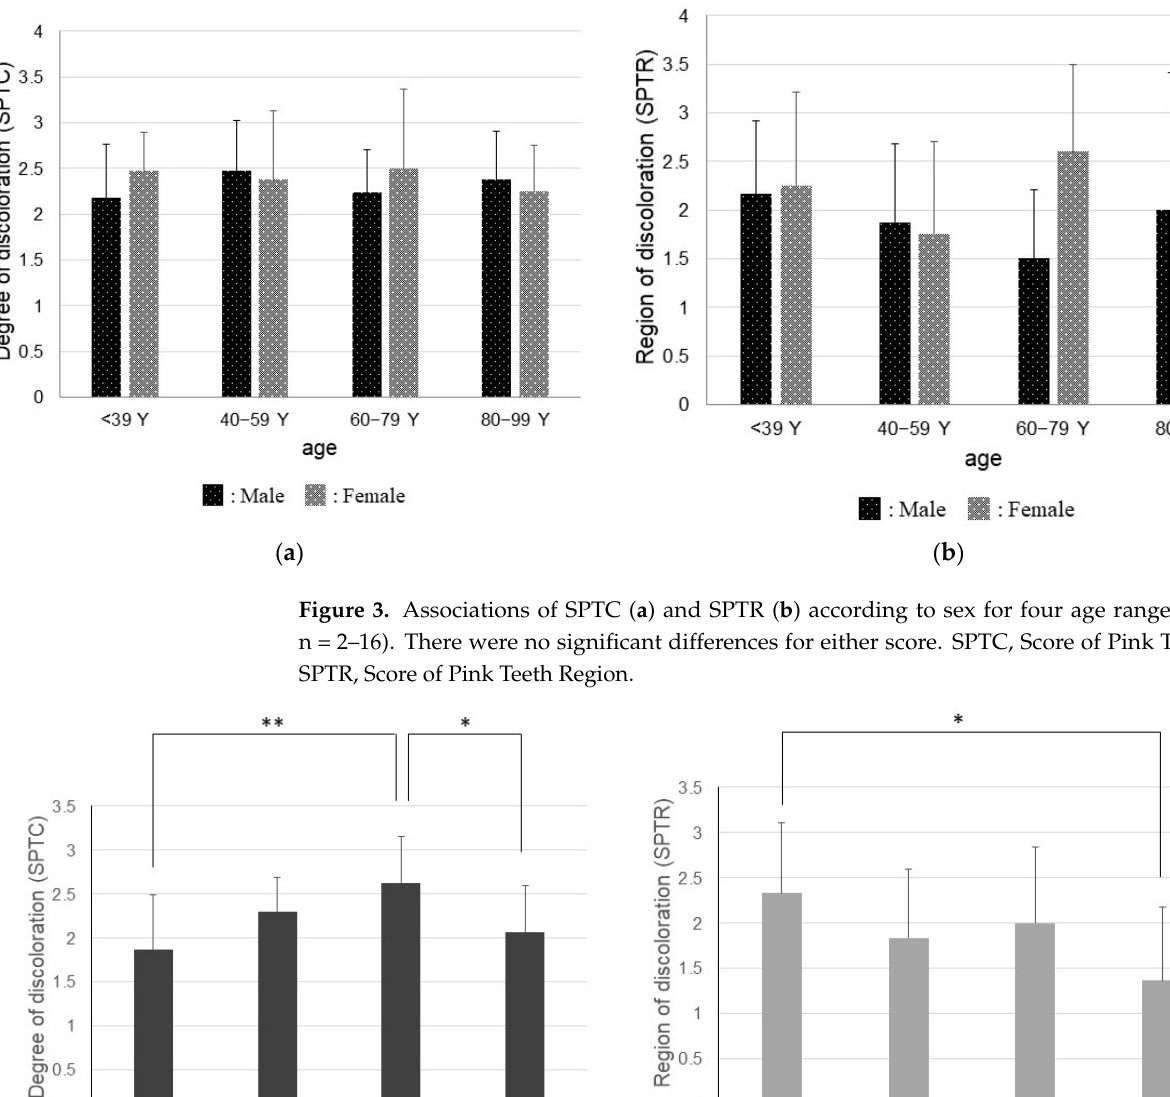
( b ) Figure 5. Association of SPTC ( a ) and SPTR ( b ) with cause of death (31 cases, n = 3–18). There were no significant differences for either score. SPTC, Score of Pink Teeth Color; SPTR, Score of Pink Teeth Region.